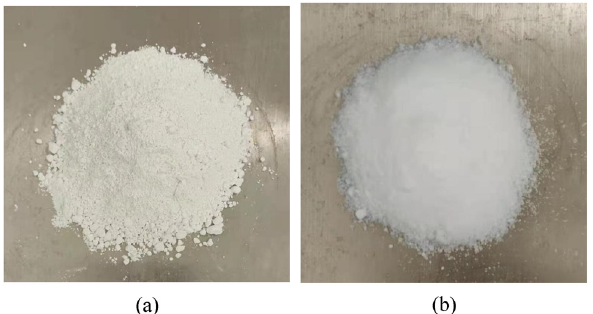
Figure 2: Photos of ( a ) SF and ( b )